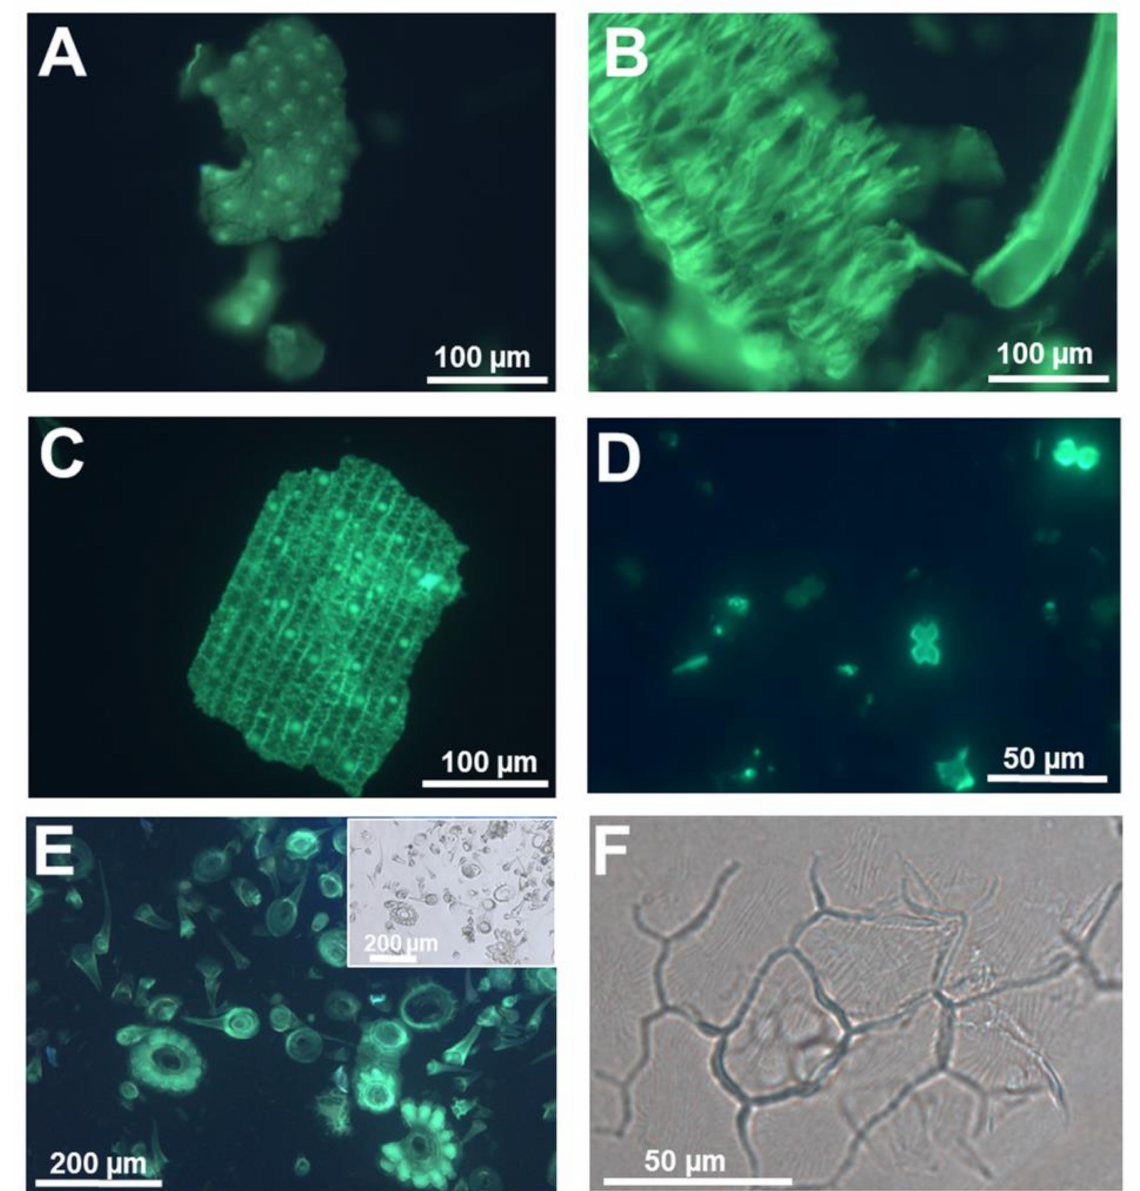
Figure 2. Silica extracted from a silicifier ( Oryza sativa L.) and non-silicifier ( Cannabis sativa L.) ( A ) Silica stained with PDMPO and extracted from rice seedlings at the 4 th leaf stage. Punctate silicified warts are present on the surface. ( B ) Silica stained with PDMPO and extracted from rice seedlings at the 3 rd leaf stage. The feathery elements are likely whiskers on the surface of husks. ( C ) Silica from rice leaf epidermis showing silicified papillae, nodules and interlocking sinuate pattern of the epidermal cell walls. ( D ) Silica and bulliform cells from rice leaf epidermis. ( E ) PDMPO staining of silica collected following acid and microwave digestion of hemp leaves and showing trichomes with / without basal cells. Inset: di ff erential interference contrast image. ( F ) Di ff erential interference contrast image of silica extracted from hemp leaves and showing a group of epidermal cells with details of the waxy wrinkles on the surface. Images were taken using an Olympus BX50 fluorescence